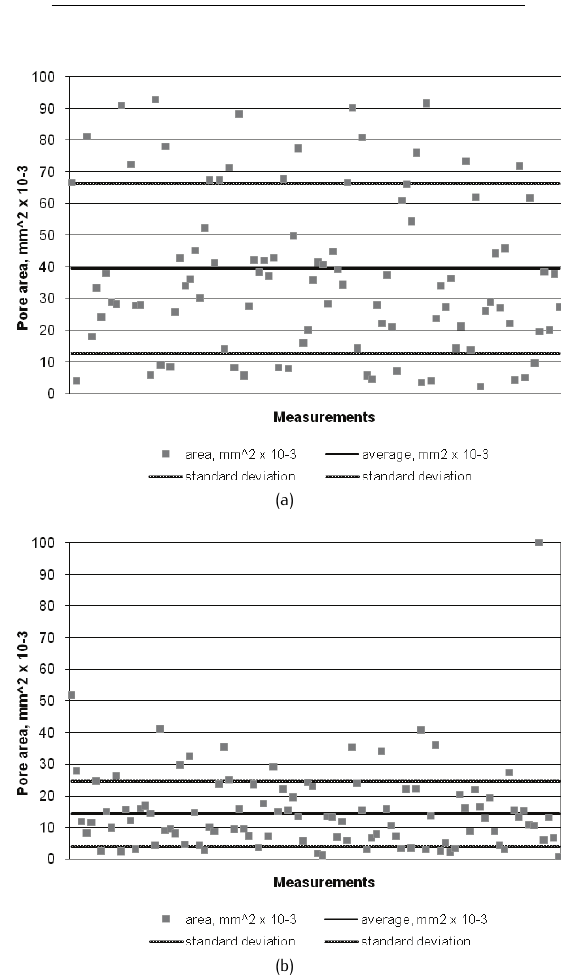
4. Pore shape transformation